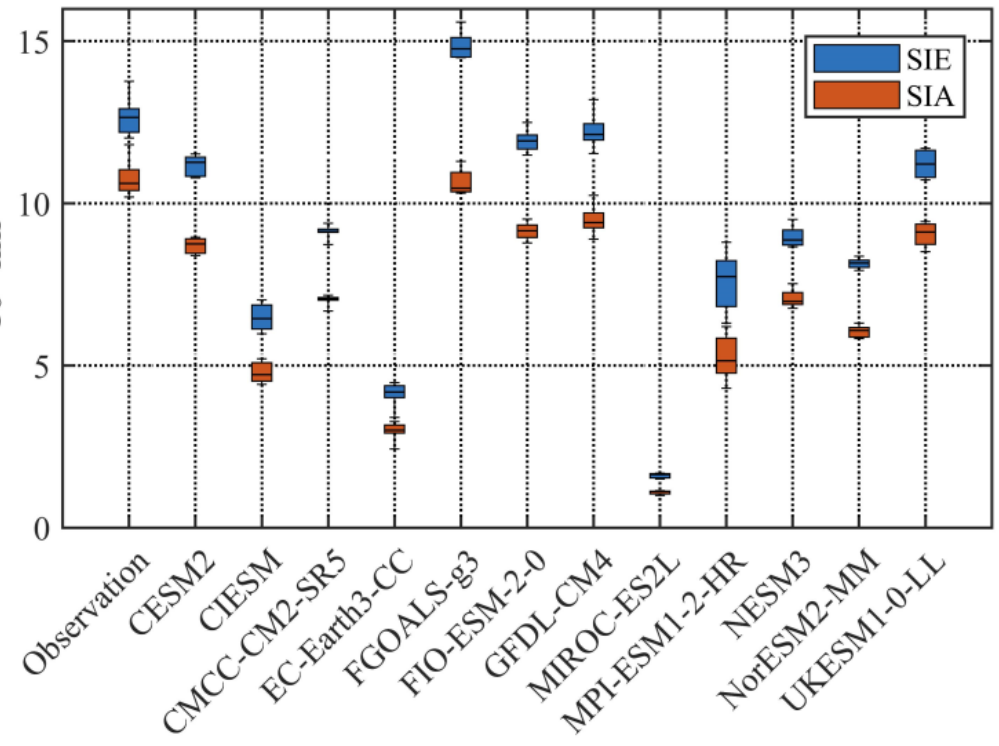
Figure 7. Interannual comparison of SIE and SIA between the CMIP6 models and the observation. The box covers the inter-quartile range with the solid line inside the box representing the median value. Whiskers denote the maximum and minimum values.